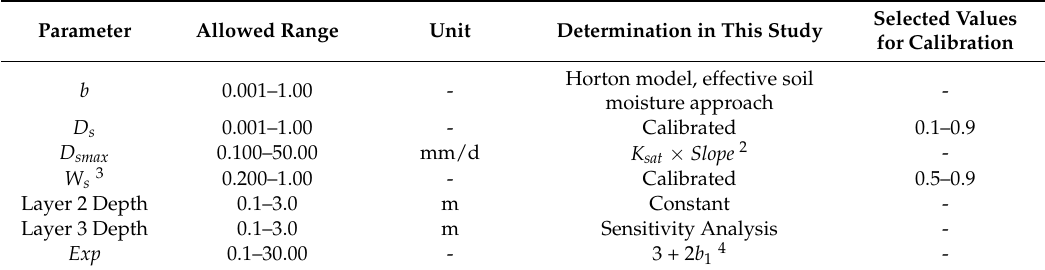
Table 1. Description and determination method of model parameters 1